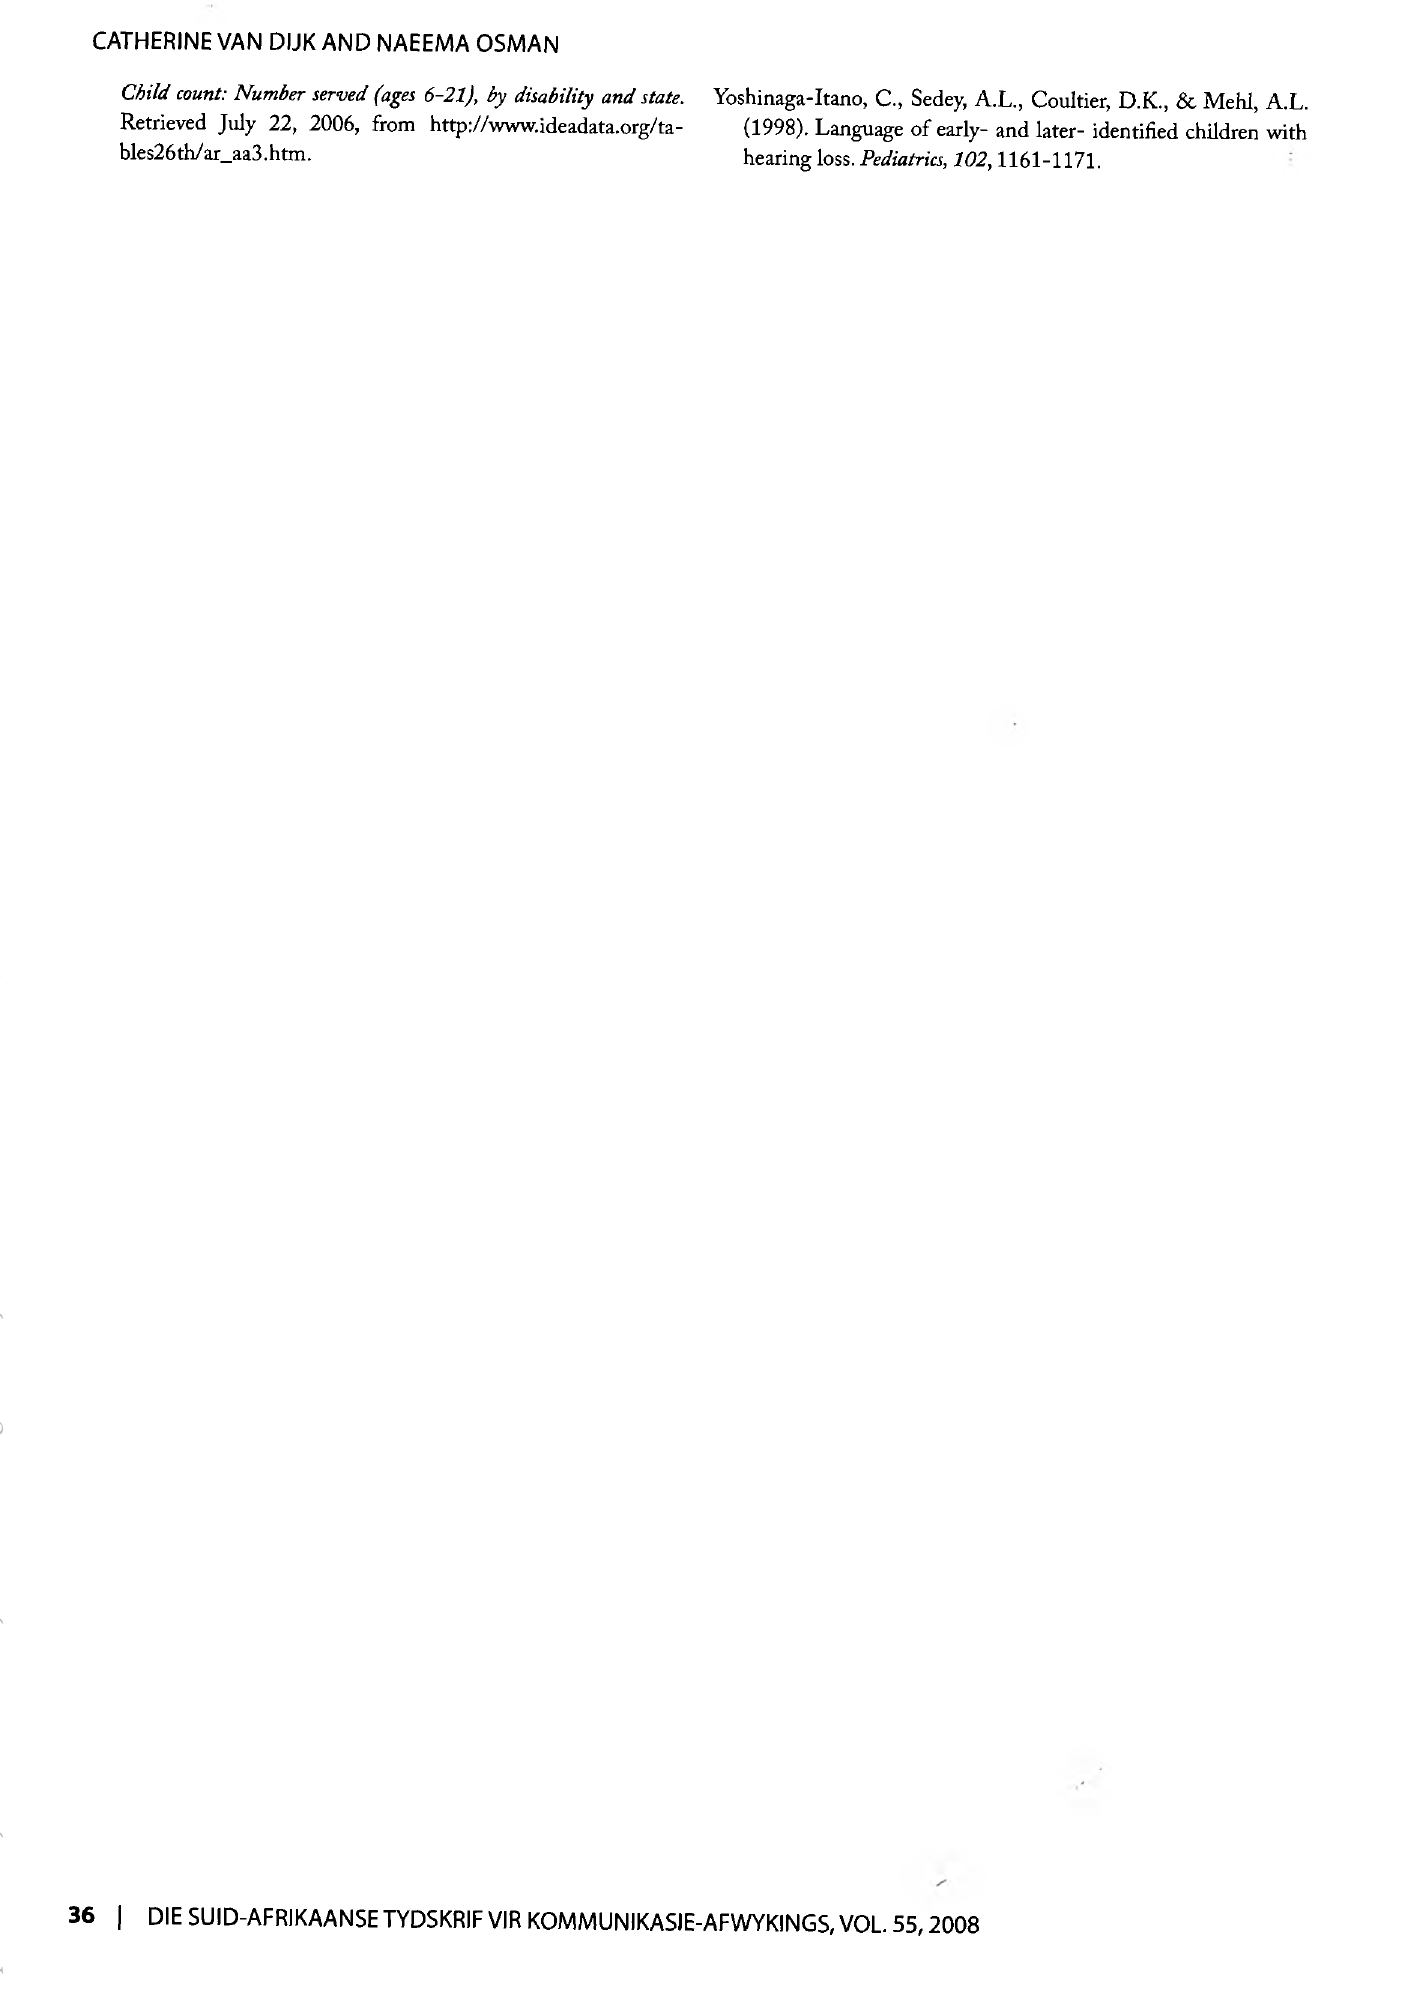
Child count: Number served (ages 6-21), by disability and